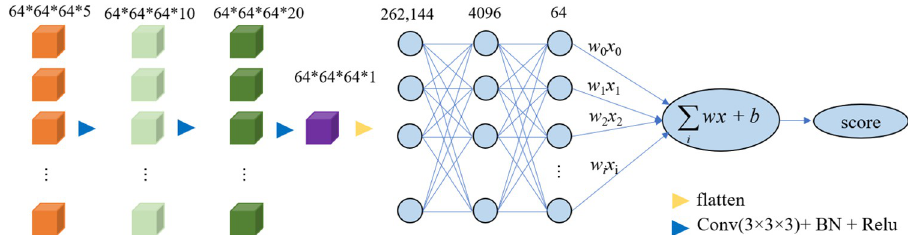
Fig 5. Creating a neural network to predict fluid intelligence score. “Flatten” operation is converting the data into a 1-dimensional array for inputting it to the next layer, and “Conv(3 × 3 × 3) + BN + ReLU” refers to 3 × 3 × 3 convolution filters, BN for batch normalization, and ReLU for rectified linear